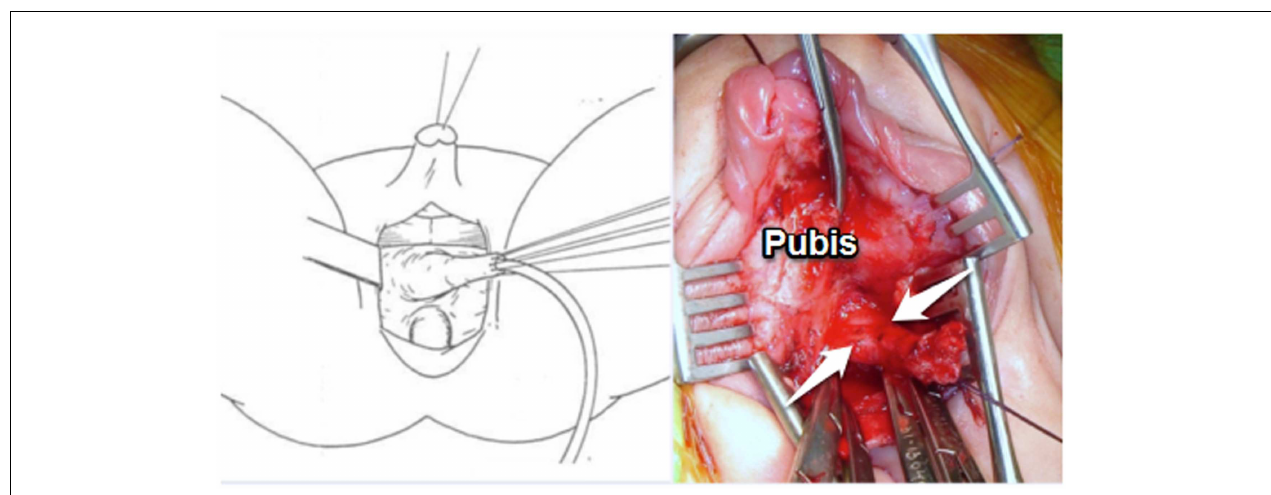
FIGURE 3 | “Total urogenital mobilization”:TUM in lithotomy position in an intermediate UGS .